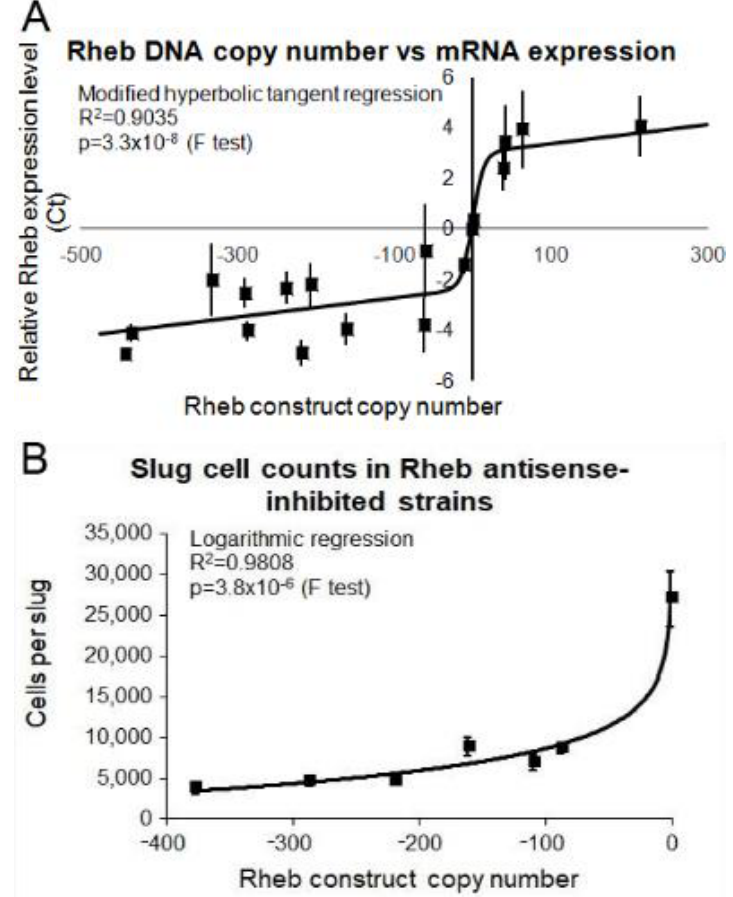
Figure 8. Correlation of Rheb antisense and overexpression copy numbers with Rheb mRNA expression. ( A ) Semiquantitative RT-PCR was performed for each of the wild type, Rheb antisense and Rheb overexpression transformants and the threshold values obtained were plotted against the measured copy number data. The experiments were repeated three times and error bars are generally too small to be seen on the graph. The regression was significant at the indicated p value (F test). The line was fitted by the least squares method to a modified hyperbolic tangent function. These data show that as the number of Rheb antisense inhibition constructs increased the level of Rheb mRNA decreased and vice versa. ( B ) The average number of cells per slug for each strain was plotted against the Rheb antisense inhibition construct copy number. At least 30 individual slugs for each strain were counted and the means were plotted with error bars representing standard deviation. The regression was significant at indicated p value (F test). The line was fitted by the least squares method to an exponential equation.